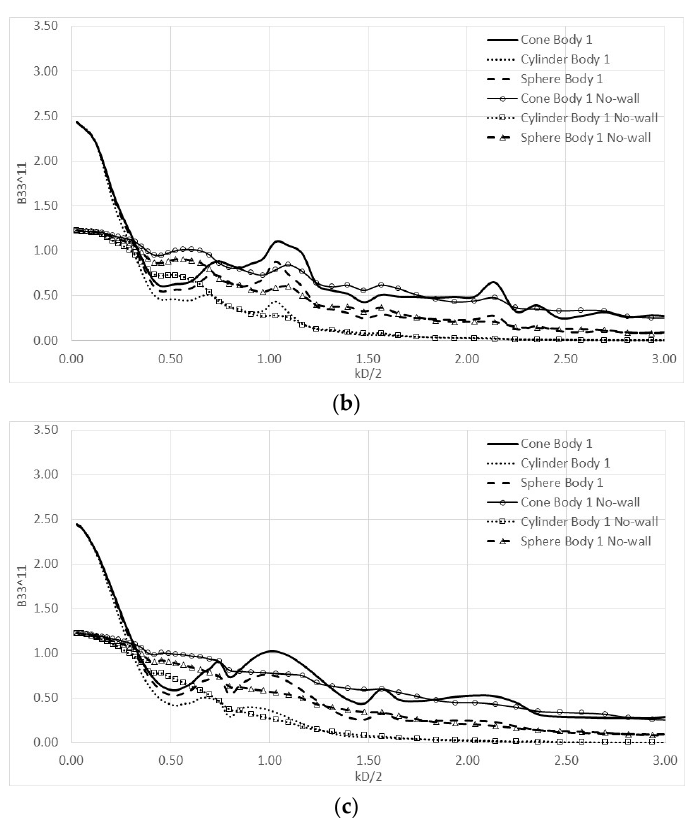
Figure 16. Dimensionless damping coefficient of the 1st floater at the heave direction due to its motion at heave against kD/2, for the three different examined array configurations. Comparison with the corresponding damping coefficient of the same floater of the arrays without the presence of the breakwater: ( a ) parallel arrangement, C 1 ; ( b ) rectangular arrangement, C 2 ; ( c ) perpendicular arrangement, C 3 .